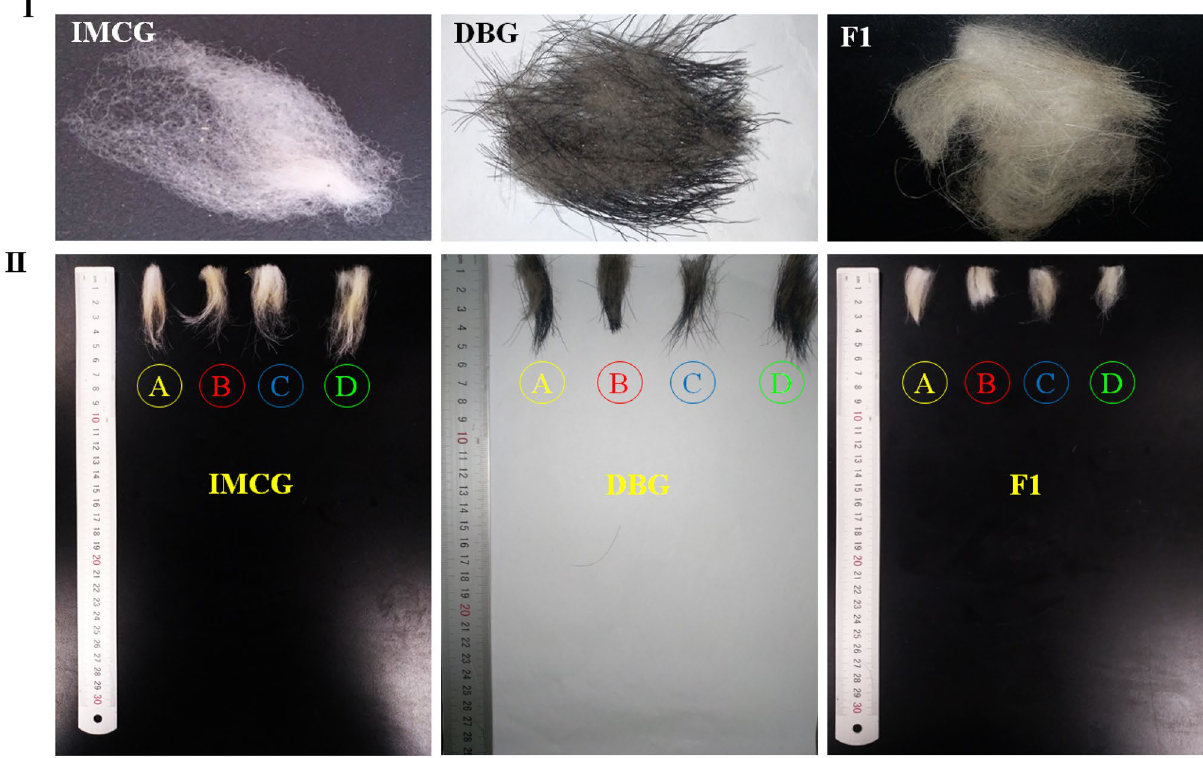
Figure 3. ( I ) Original cashmere samples and ( II ) Cashmere length of studied goat breeds; Inner Mongolia Cashmere goat (IMCG), Dazu black goat (DBG) and IMCG x DBG (F 1 ). (A) shoulder, (B) side-portion, (C) abdomen and (D) leg sites.